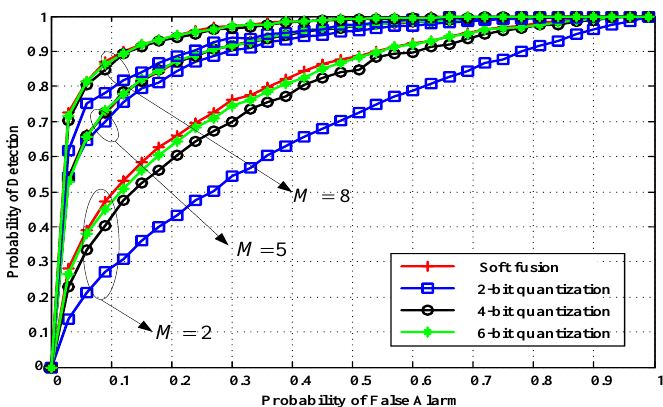
Figure 11. ROC curves for different number of cooperative SUs (SNR = −12 dB, N = 400).